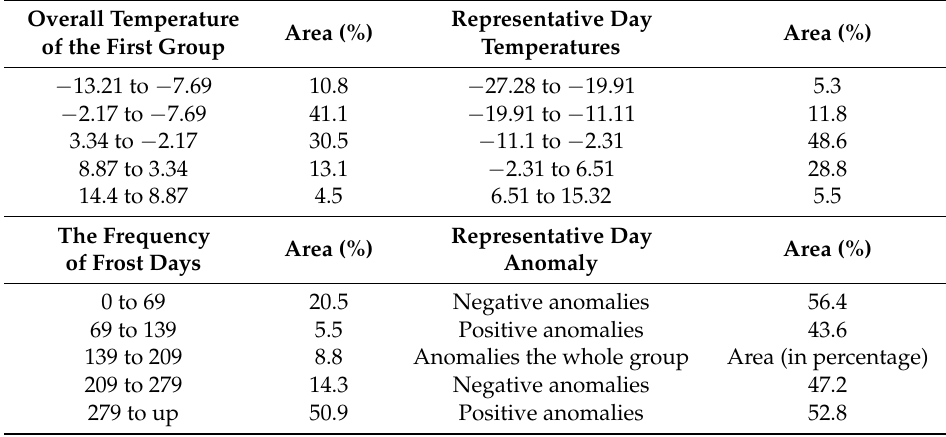
Table 2. Percentage of the covered area of different classes of average temperature, anomalies and frequency of frosts for the first